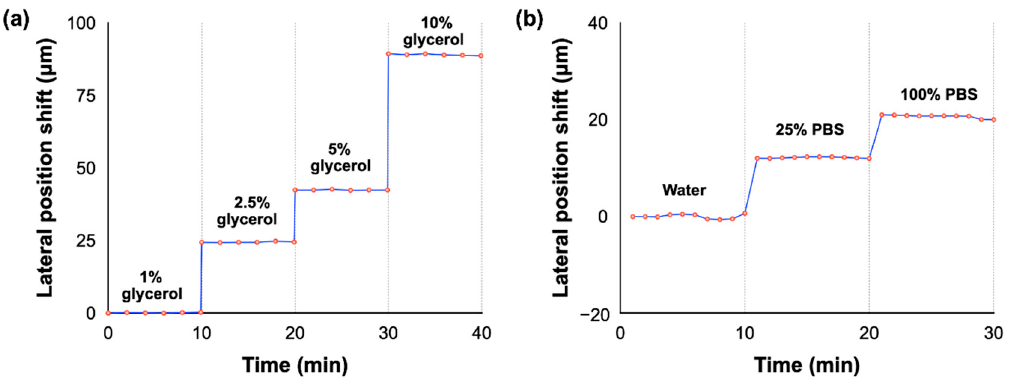
Figure 7. Real-time differential lateral position shift measurement for various weight ratios of ( a ) glycerin and ( b ) PBS solutions.